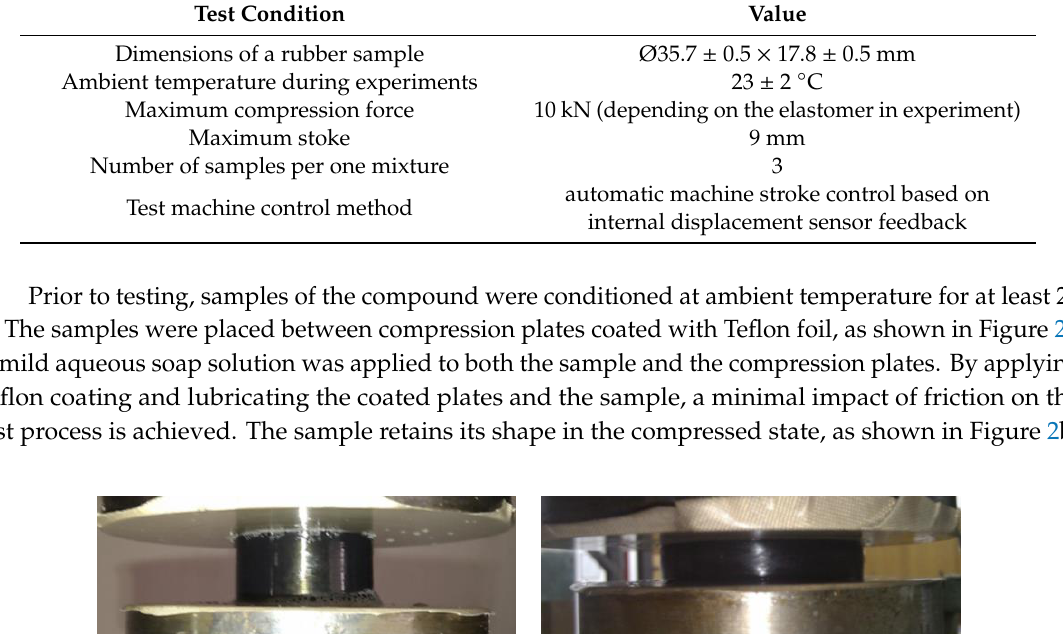
Table 4. Specification of experimental uniaxial compression of rubber samples.